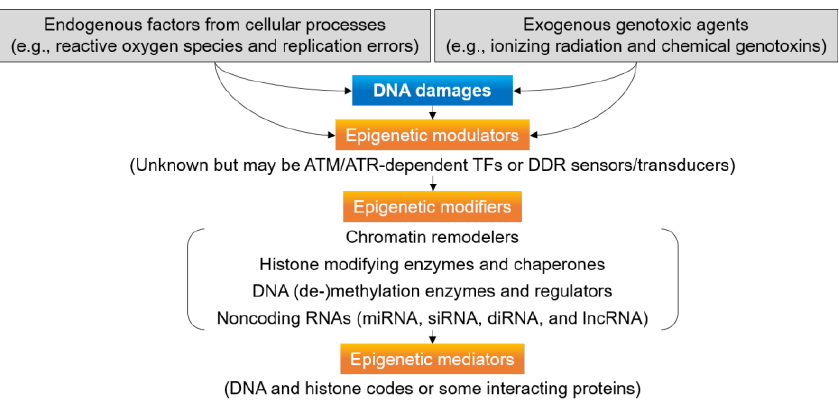
Figure 2. Epigenetic regulation of plant DDR. Epigenome integrity challenged by DNA damages mediates DDR but is restored by resetting the epigenomes structures via chromatin